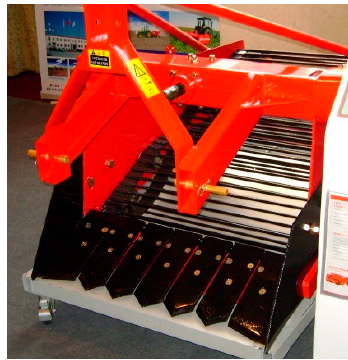
Figure 9. SH (Shandong) 11 kW 4 WT (Photo: Brian Sims) .